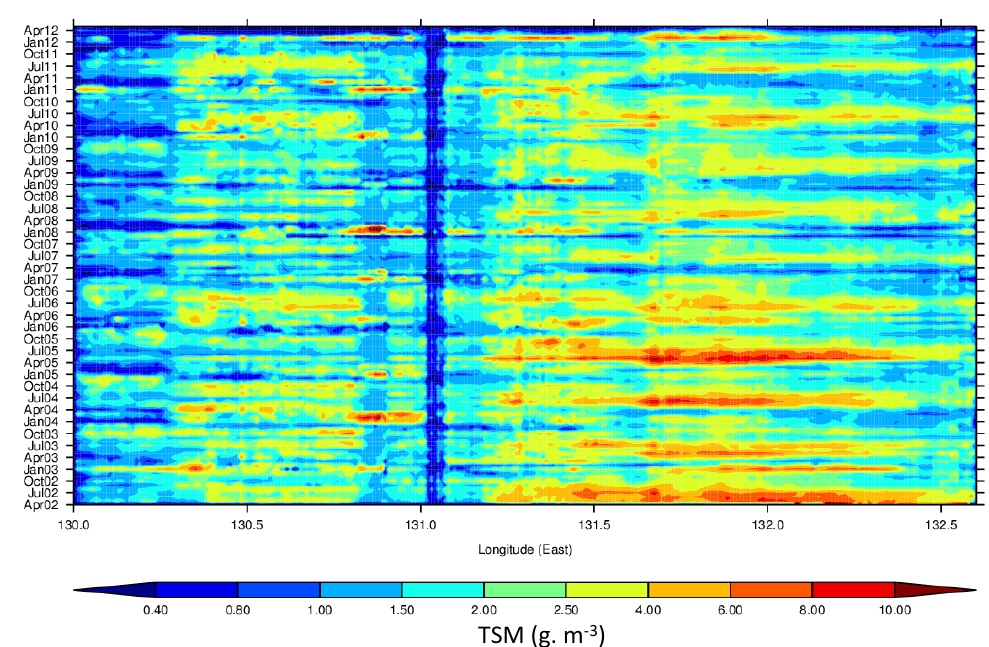
Figure 21. Longitude-time plot of TSM for the VDG